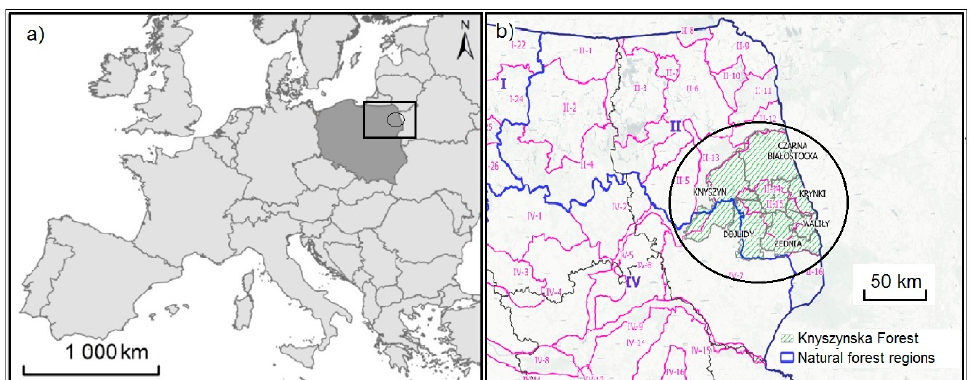
Figure 1. The research area in Poland ( a ) and the Knyszynska Forest within the Second Natural Forest Region ( b ).